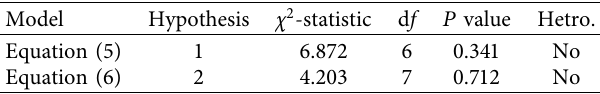
Table 5: The results of heteroscedasticity of the error